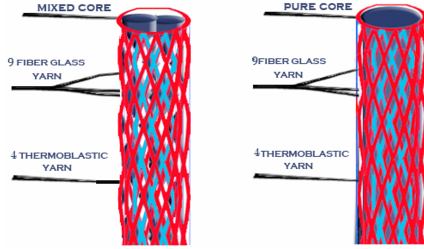
Figure 7. Sample 5 with different cores.